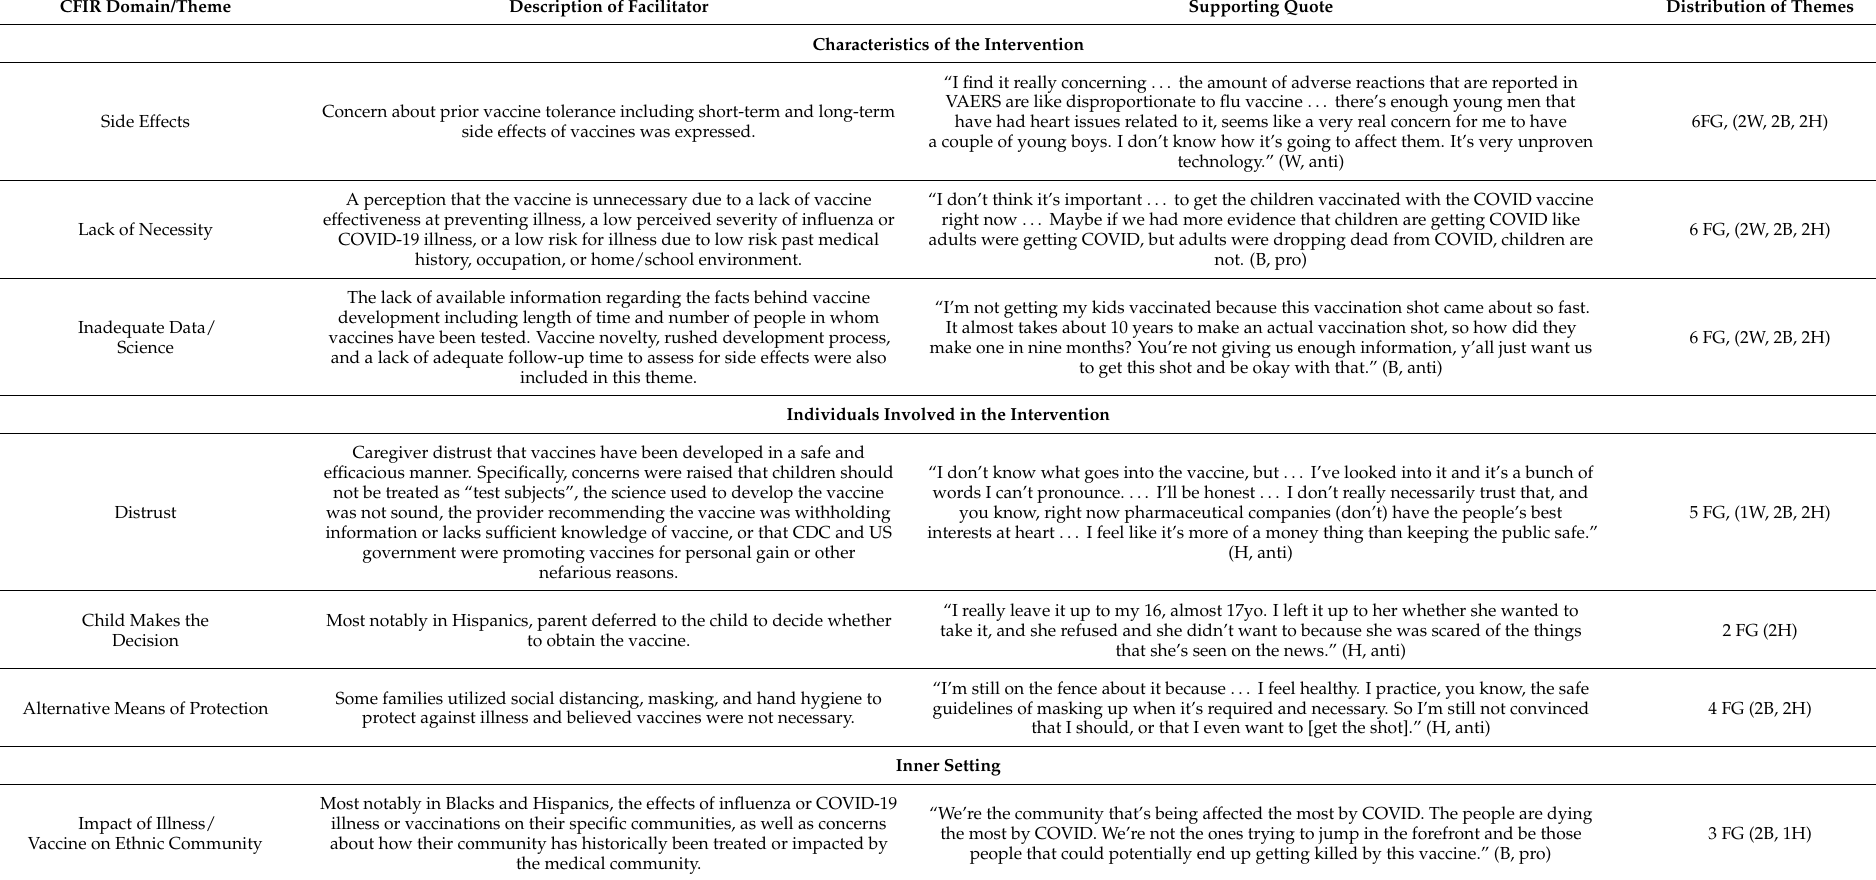
Table A4. Barrier Themes to Influenza and SARS-CoV-2